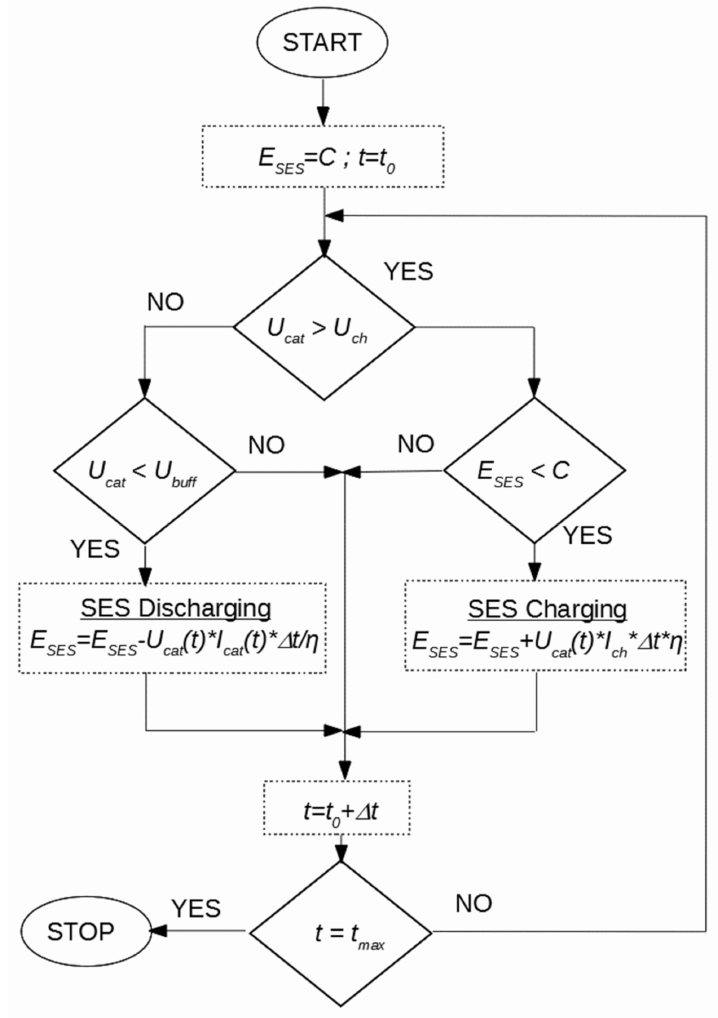
Figure 8. The scheme of r calculation algorithm: C—the capacity of BS battery, E SES —actual en- ergy accumulated in BS battery, U cat (t), I cat (t) —actual catenary voltage and BS load current (from registration), t max —duration of the registration, η